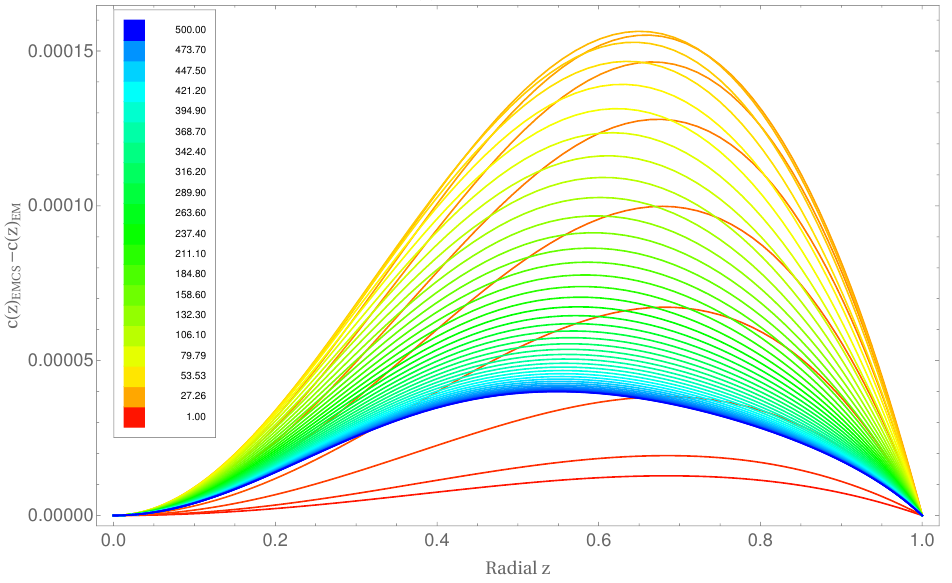
Figure 23 . We display the difference between the metric function c ( z ) for full solutions to Einstein- Maxwell-Chern-Simons theory and the Einstein-Maxwell theory. The inset legend displays the coloring for different values of B/T 2 .